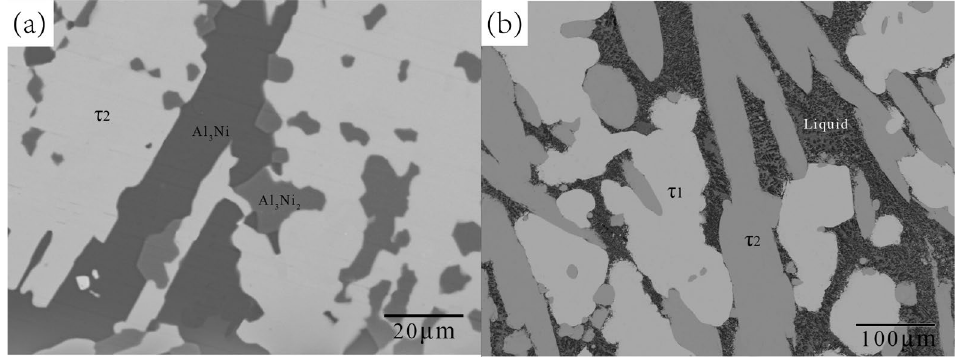
Figure 12. BSE images of Samples ( a ) B1 and ( b ) B7.